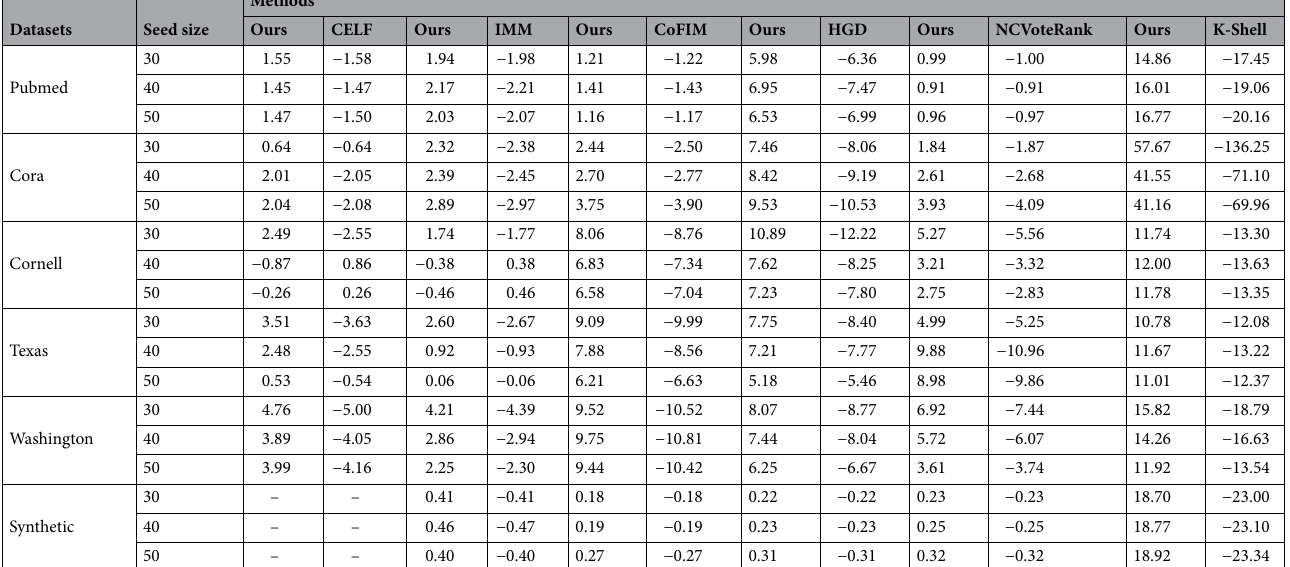
Table 4. Speedup % (in terms of influence spread) for ours versus other baseline methods on six datasets. The propagation is simulated on the IC model.